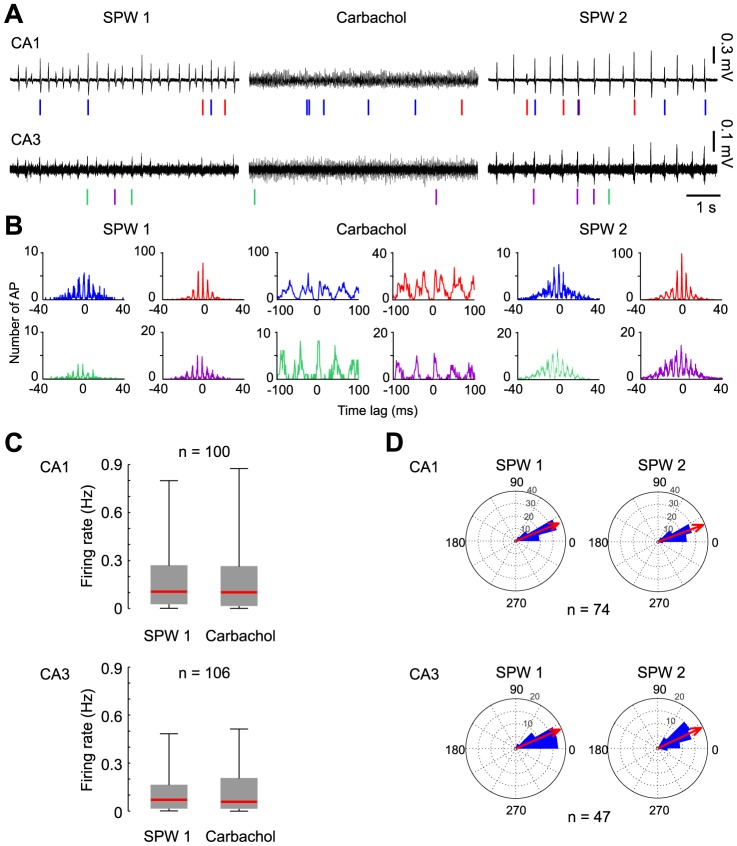
Hippocampal units maintain coupling precision to the local field potential during alternating network states.
A: Local field potential recordings and single unit activity (symbolized by vertical ticks) in CA1 and CA3 during the three experimental steps of the CCh experiments: baseline recording (SPW 1, left panel) followed by carbachol-induced gamma oscillations (Gamma, middle panel) and re-established SPW by wash-in of atropine (SPW 2, right panel). Two representative units are indicated by colored ticks in each region. Note that the individual units could be observed in all three phases of the experiment. B: Event cross-correlograms of field-potentials and firing time points of the units depicted in A. During SPW 1 and SPW 2, unit firing is correlated to the ripple-oscillation troughs in CA1 (peak intervals at ∼5 ms, corresponding to ripple cycle length); during the gamma episode they are correlated to the local gamma oscillation troughs (peak intervals at ∼30 ms). C: Mean firing rates of units remain constant during gamma oscillations. D: Firing phases of units to ripple troughs remain stable after an intermittent episode of gamma oscillations. The ripple cycle is described by a circular scale of 360° and the ripple trough is set to 0°. Each unit's preferred firing phase angle to the ripple contributes as one data point. Mean angle of the sum of all units is represented by the red arrow. The length of the red arrow is proportional to the length of the vector corresponding to the mean angle.